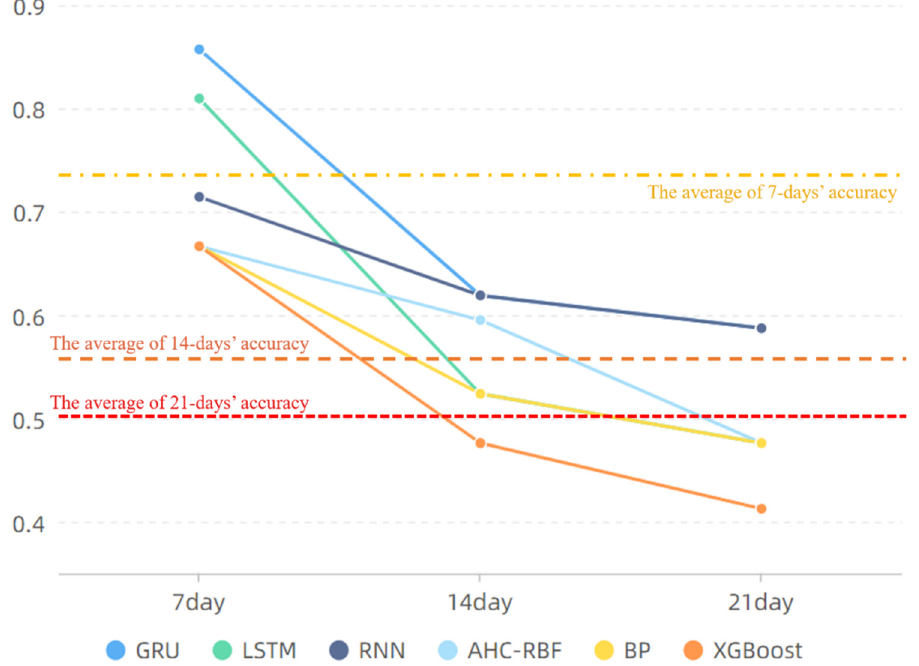
Figure 15. Correct rate of each